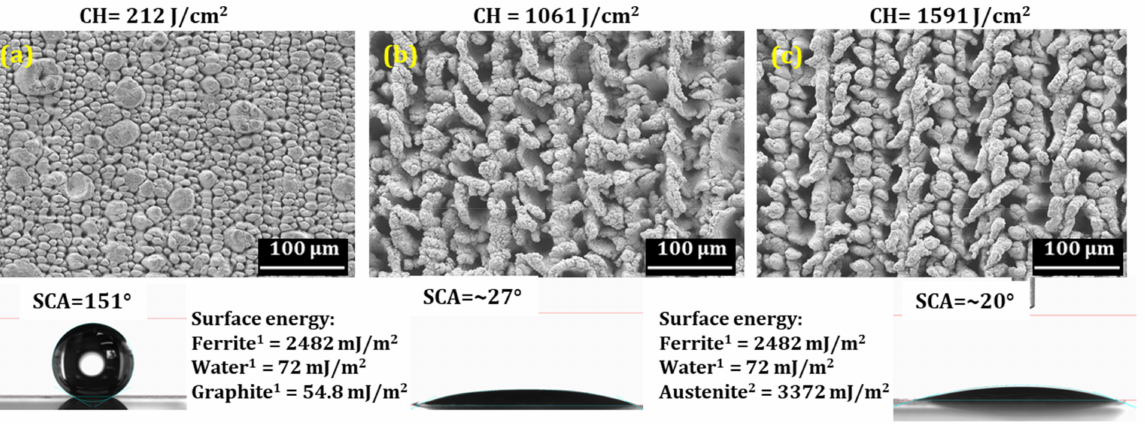
Figure 7. SCA comparison with structures and different phases obtained at various CH ( a ) 212 J/cm 2 , ( b ) 1061 J/cm 2 and ( c ) 1591 J/cm 2 .